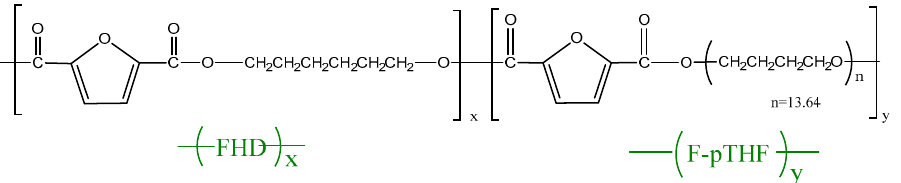
Figure 1. Structure of poly(hexamethylene 2,5-furanodicarboxylate)-block-poly(tetrahydrofuran) (PHF- b -F-pTHF copolymers).